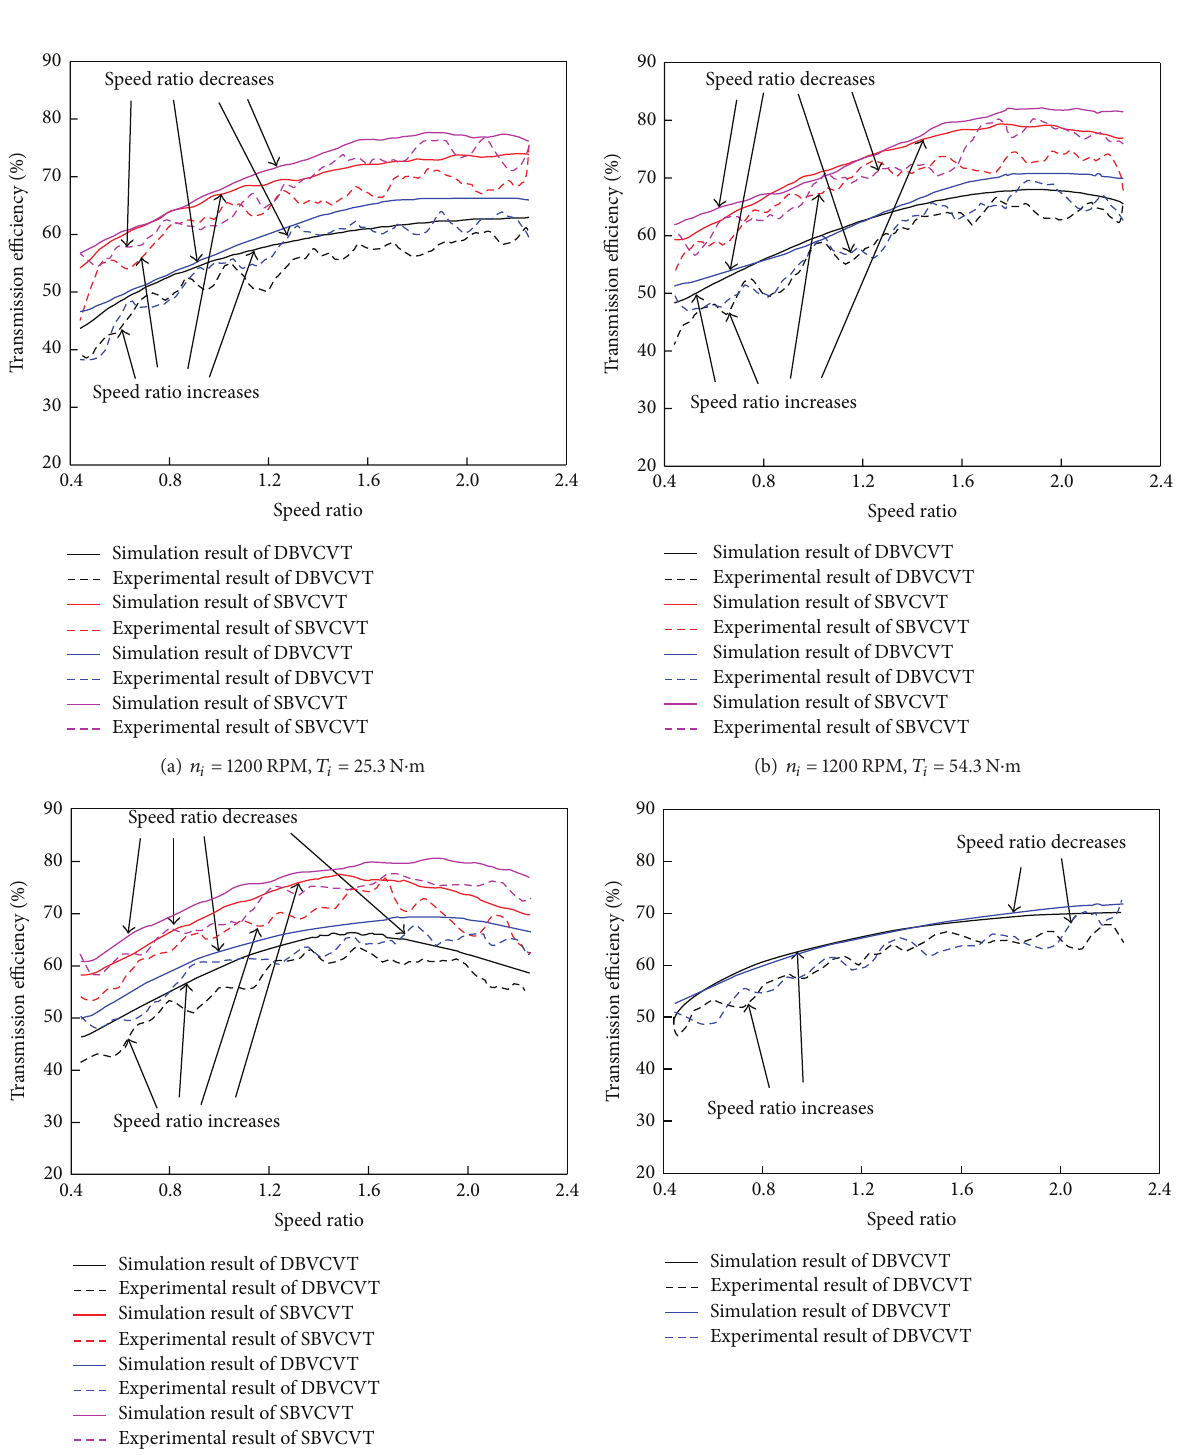
Figure 14: Comparison of simulation and experimental results of transmission efficiencies under 𝑛 𝑖 =